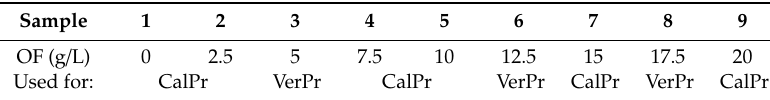
Table 3. The concentration of OF in the experiment. Calibration process (CalPr) and Verification process (VerPr).